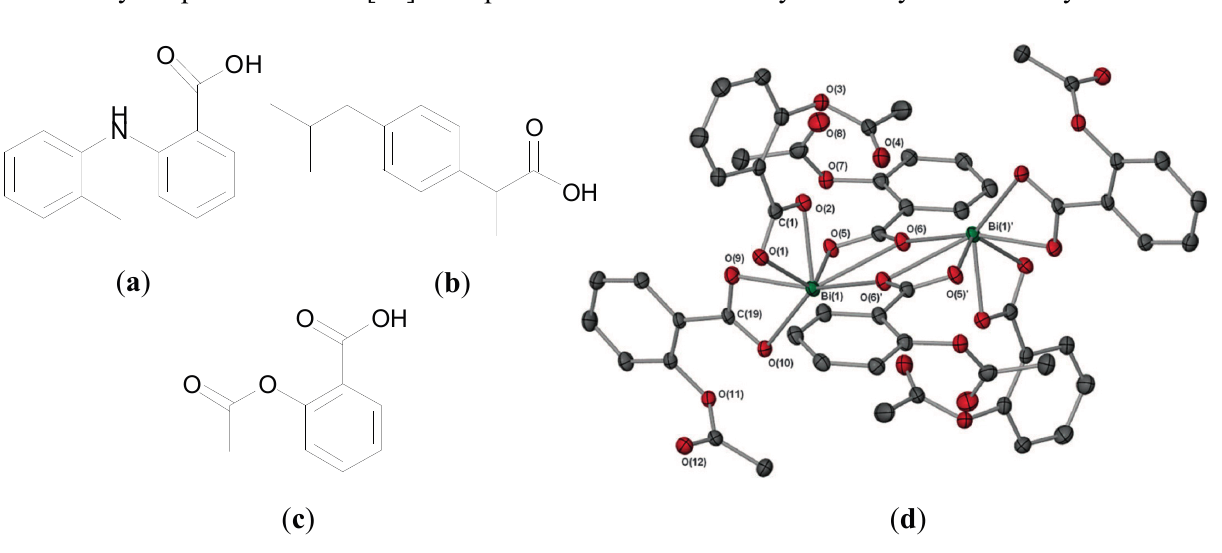
Figure 8. Structures of: ( a ) ibuprofen, ( b ) mefenamic acid and ( c ) acetylsalicylic acid (aspirin); ( d ) Molecular structure of [Bi(asp) 3 ] ∞ . Hydrogen atoms have been omitted for clarity. Reproduced from [80] with permission from The Royal Society of